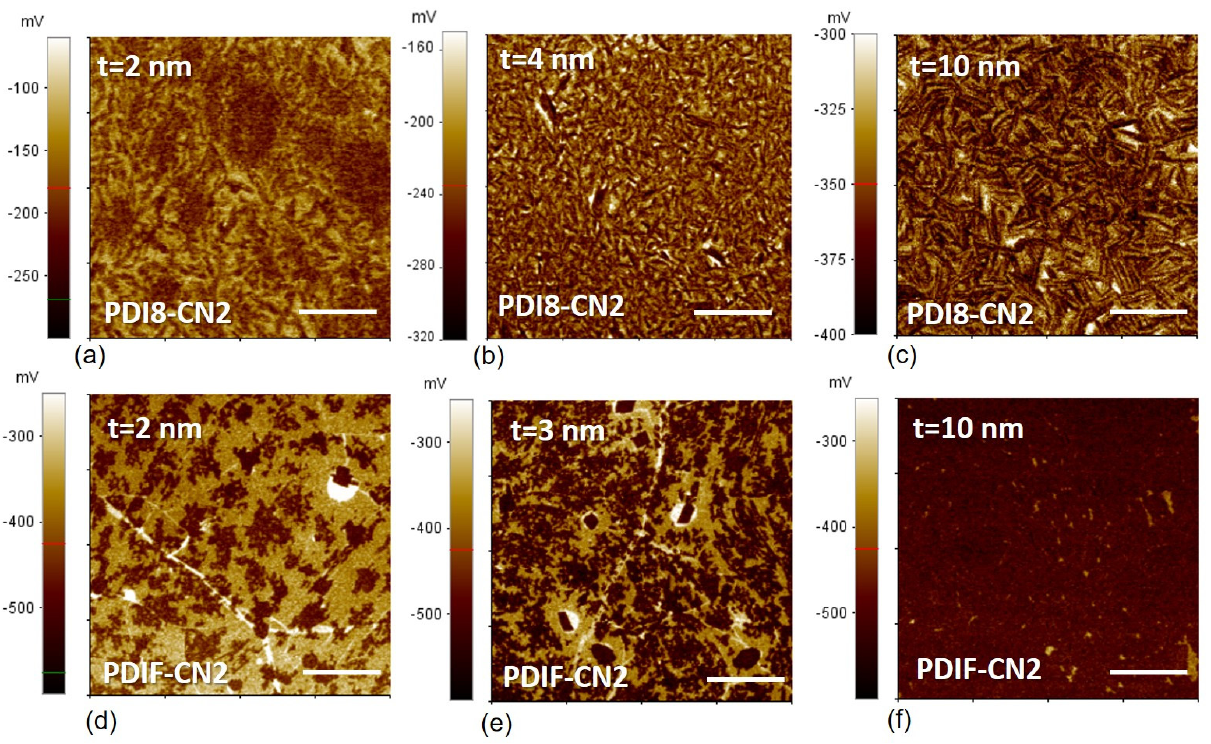
Figure 5. Surface potential maps (10 µm × 10 µm, 256 × 256 pxl) for the PDI8-CN2 ( a – c ) and for the PDIF-CN2 ( d – f ) grown on the graphene substrate, as a function of the nominal thickness t. The white bars correspond to 2.5 µm.